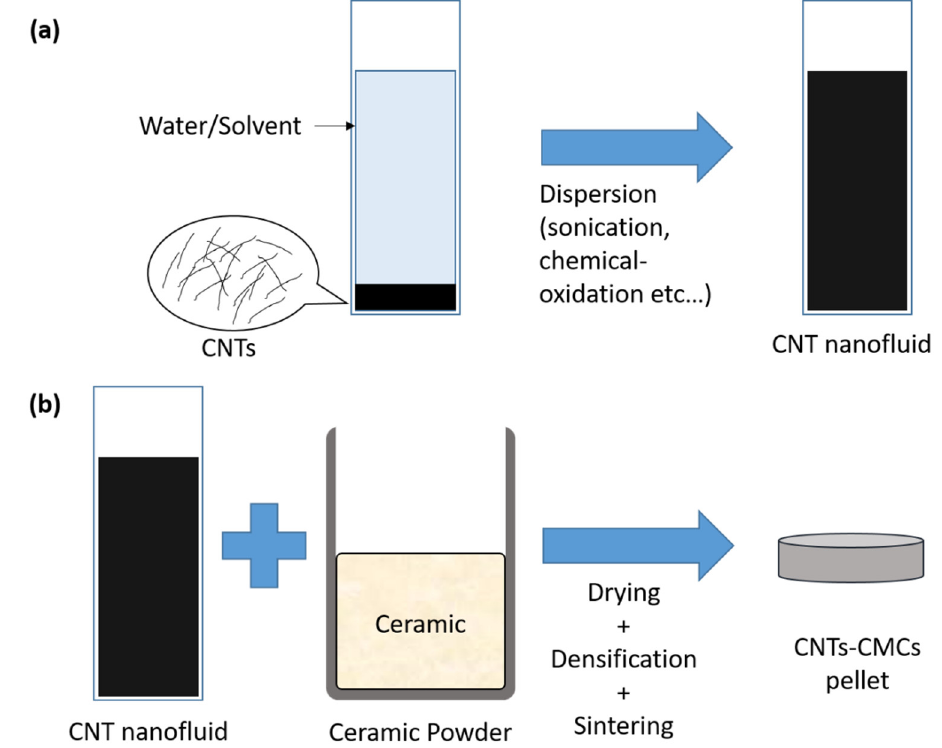
Figure 5. Schematic diagram of colloidal processing. ( a ) Dispersing CNTs into CNT nanofluid and ( b ) ceramic powder mixed with CNT nanofluid, which dried out the moisture, densified and sintered into CNTs-CMCs pellets.